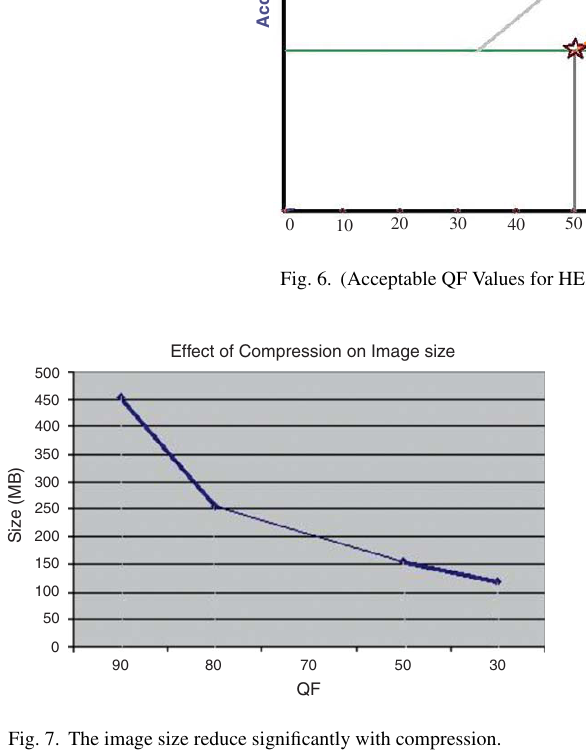
Fig. 7. The image size reduce significantly with